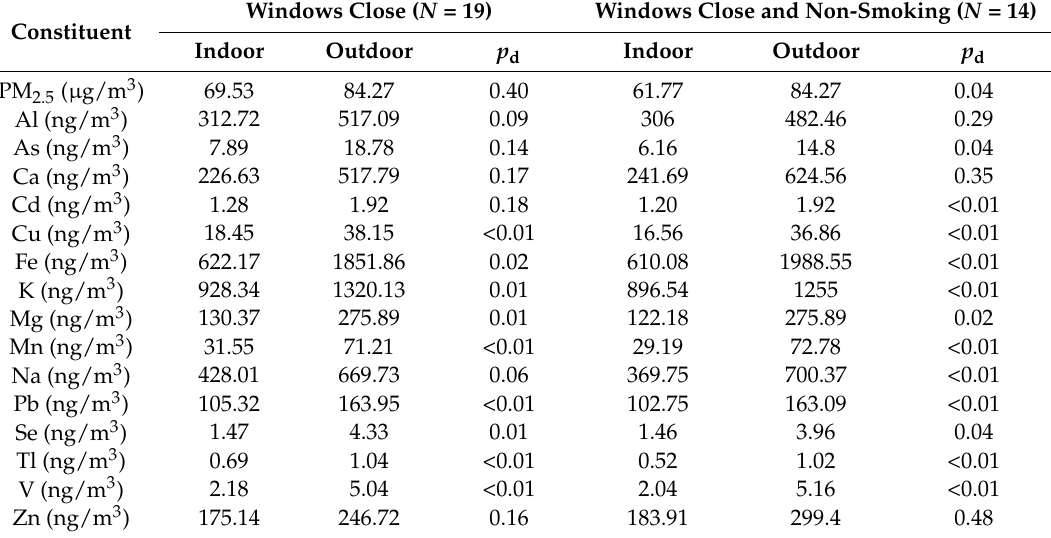
Table 4. Comparison of indoor and outdoor concentrations of PM 2.5 and elements for houses with window close in HS